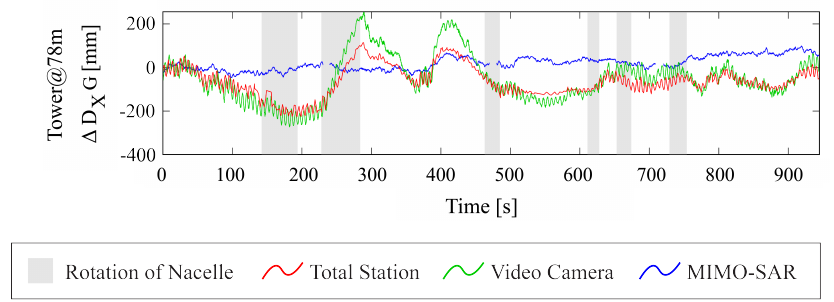
Figure 11. Deformation ∆ D of the wind turbine tower at heights of 78m above the X G